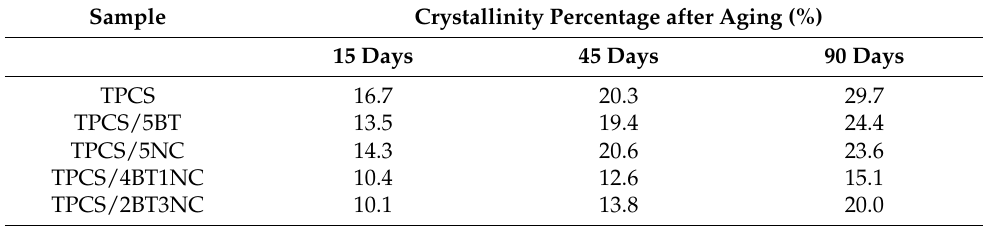
Table 3. The changes in the crystalline percentage of TPCS, TPCS-C, and TPCS-HC films after 15, 45, and 90 days of